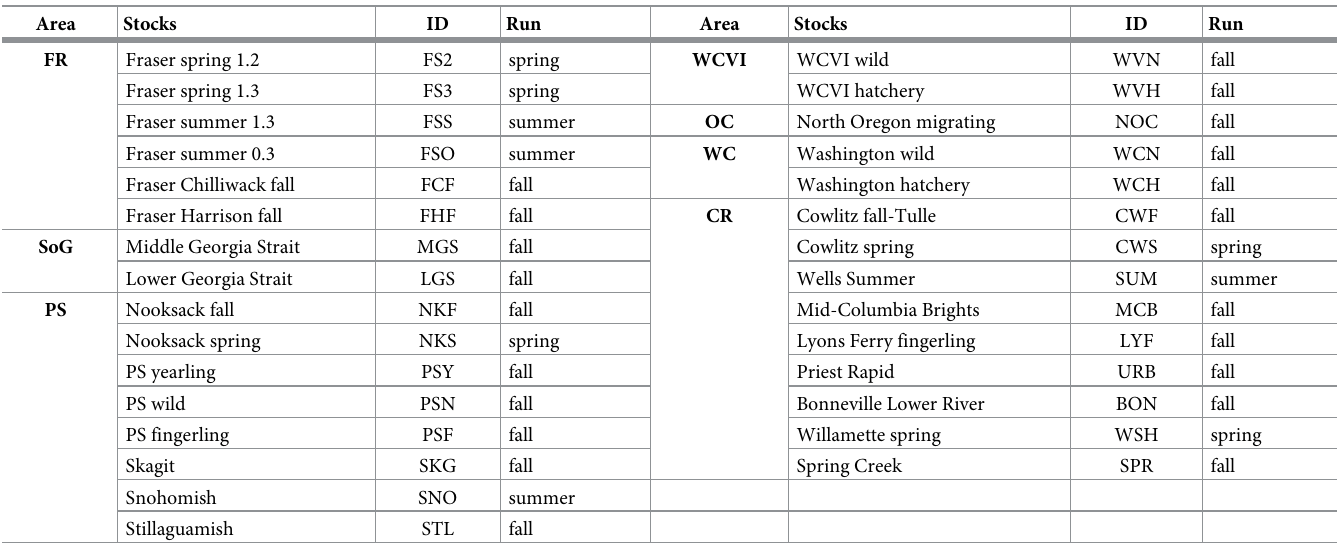
Table 1. List of the 30 Chinook salmon stocks of interest for